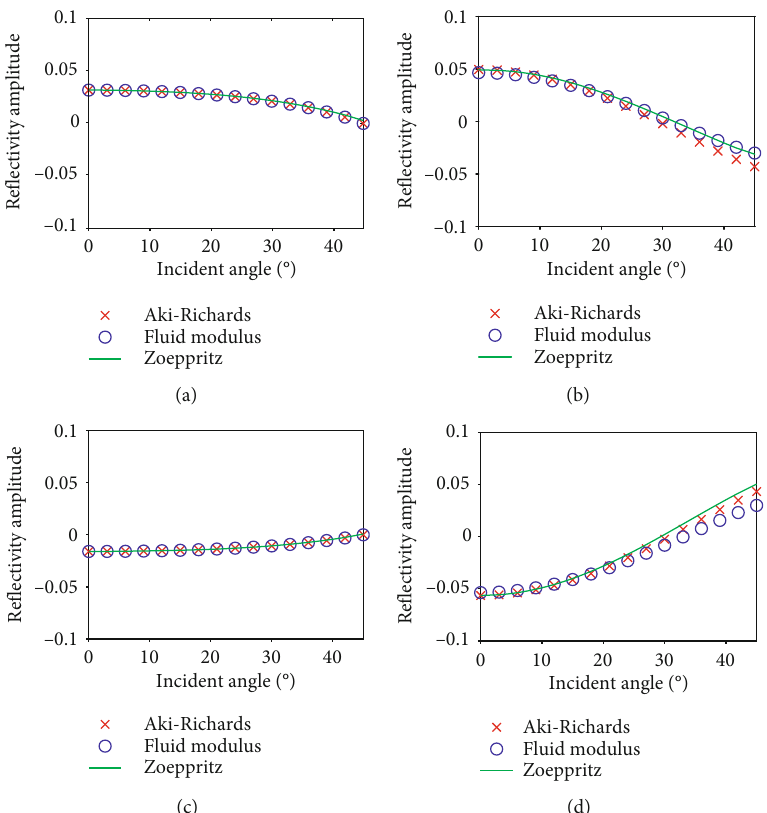
Figure 2: AVO curves corresponding to the Zoeppritz equation (green solid line), the Aki-Richards approximate equation (red cross), and our fl uid modulus approximation (blue circle) at the incident angle ranging from 0 ° to 45 ° : (a) Model 1, (b) Model 2, (c) Model 3, and (d) Model 4 listed in Table